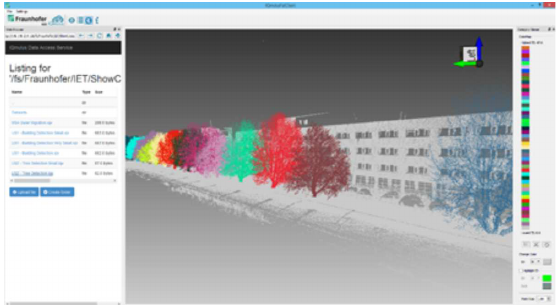
Figure 10. Individual tree visualization using the Fat